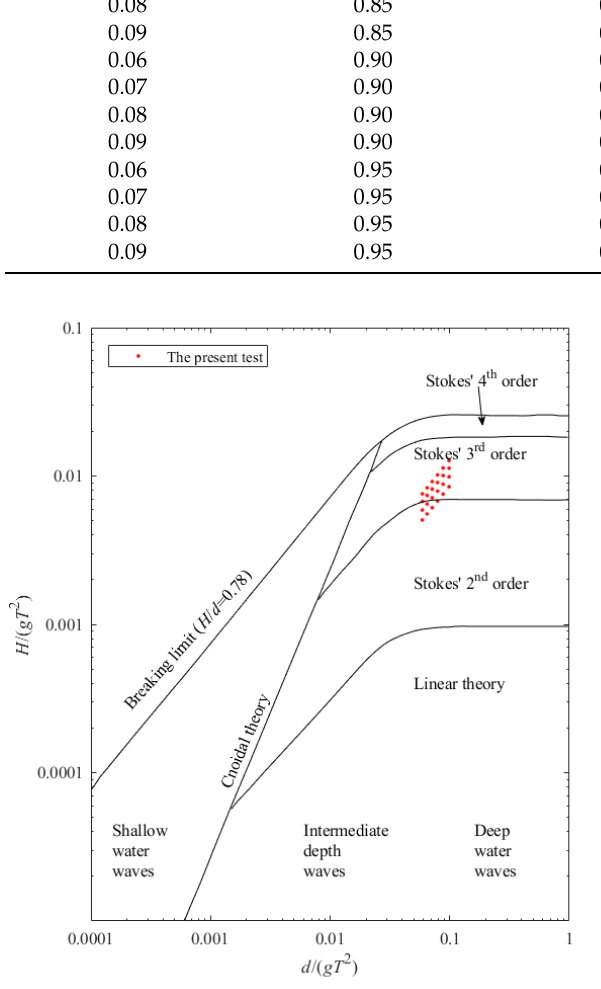
Figure 2. Relationship between wave theories and test waves; the red marks denote the test waves.